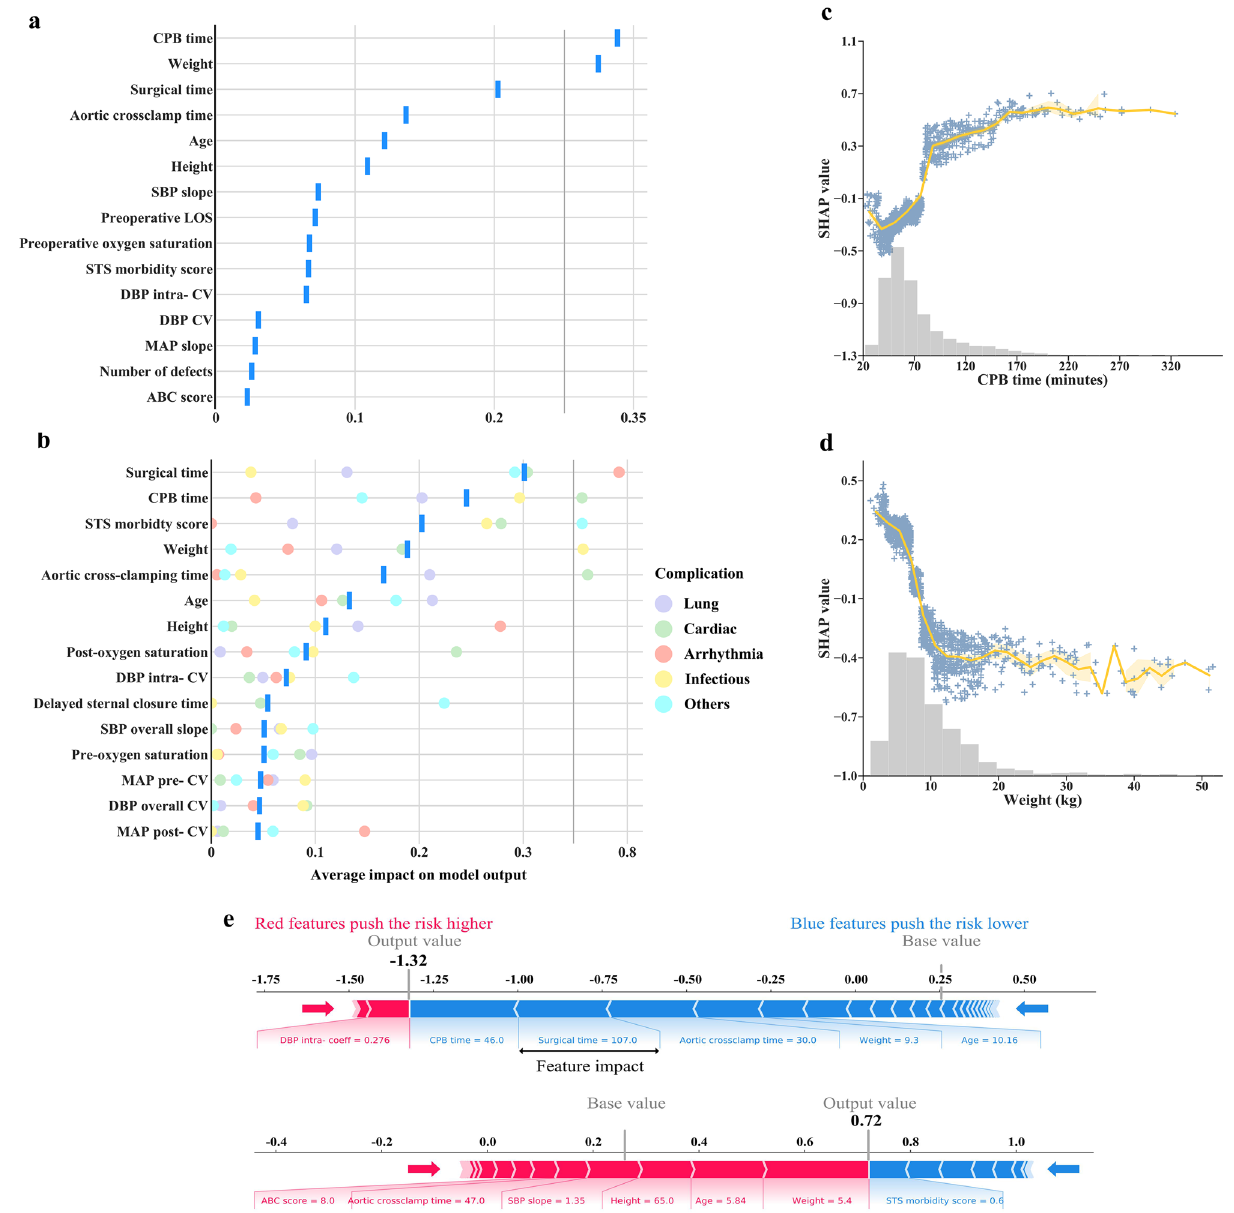
Figure 4. Feature inspection. (a,b) Importance estimates assigned by our proposed method to the top 15 features in both the binary (a) and multi-label (b) classification. The importance of features in multi-label classification was measured as the averaged feature importance estimated by five categories of complication prediction, and the feature importance of each category prediction was represented by different colored circles. (c,d) Scatter plots showing the relationship between the varying feature and SHAP value for CPB time (c) and patient weight (d) . The gray histogram shows the distribution of values for that feature in the training set. The orange line and shade represent the mean and the 95% confidence interval of the regression line. (e) Visualization of two individual examples for the explanation risk of postoperative complications. Each feature contributes to pushing the model output from the base value (the average model output over the training dataset we passed) to the model output. Red features mean pushing the prediction higher risk and blue features pushing the prediction lower blood pressure readings are all from normal to lower and finally back to normal. For the analysis of postopera- tive outcomes, the complexity of cardiac surgery was considered an important risk factor in other studies 13 . The length of surgical time indirectly reflects the complexity of the surgery. When using this model to generate early warnings before complications occur, it is important to understand the balance between recall (the sensitivity) and precision. Given that the ratio of positive to negative in our data is unbalanced, especially for specific complication types, we adjust one weight parameter in the model which